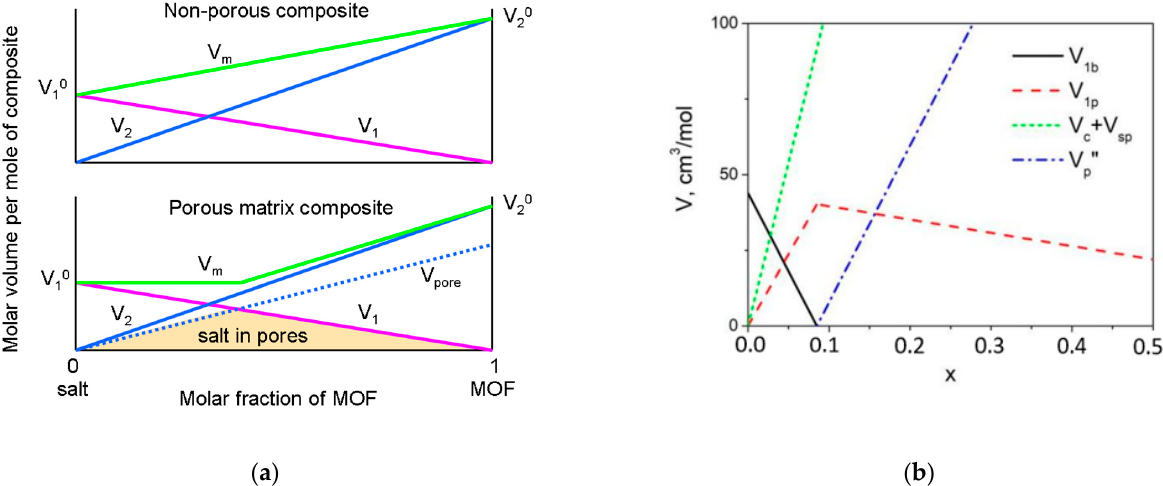
Figure 4. ( a ) The variation of molar volumes (per mole of the composite) with the molar fraction of the additive) for the composite (V m , green line), initial salt (V 1 , magenta line) and the additive (V 2 , blue line) which were taken for preparation of the composite in the case for non-porous additive (upper plot) and porous matrix composite (bottom plot). The dotted line corresponds to the pore volume (V pores ); the colored region indicates the volume of the salt located in the pores. ( b ) Concentration dependences of the molar volumes (per mole of the mixture) of bulk lithium perchlorate (V 1b ), the lithium perchlorate located in the large pores (V 1p ), the cage MIL-101 together with small pores (V c + V sp ) and the volume of unfilled large pores or empty space in the large pores (V p ′′ ). The dependences were obtained from Equations (3)–(5) at x < x max and Equations (7) and (8) at x > x max using the values V 10 =44 cm 3 /mol; V p0 = 474 cm 3 /mol; V c0 = 713 cm 3 /mol; V sp0 = 387 cm 3 /mol, corresponding to x max = 0.085.